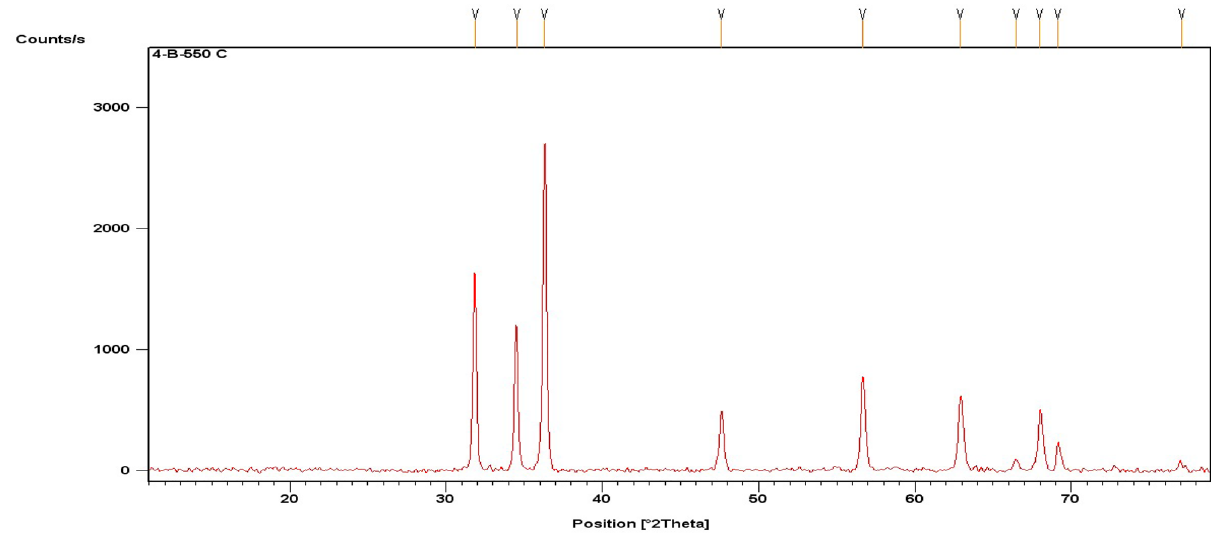
Figure 2. X-ray diffraction pattern of ZnO-NPs.